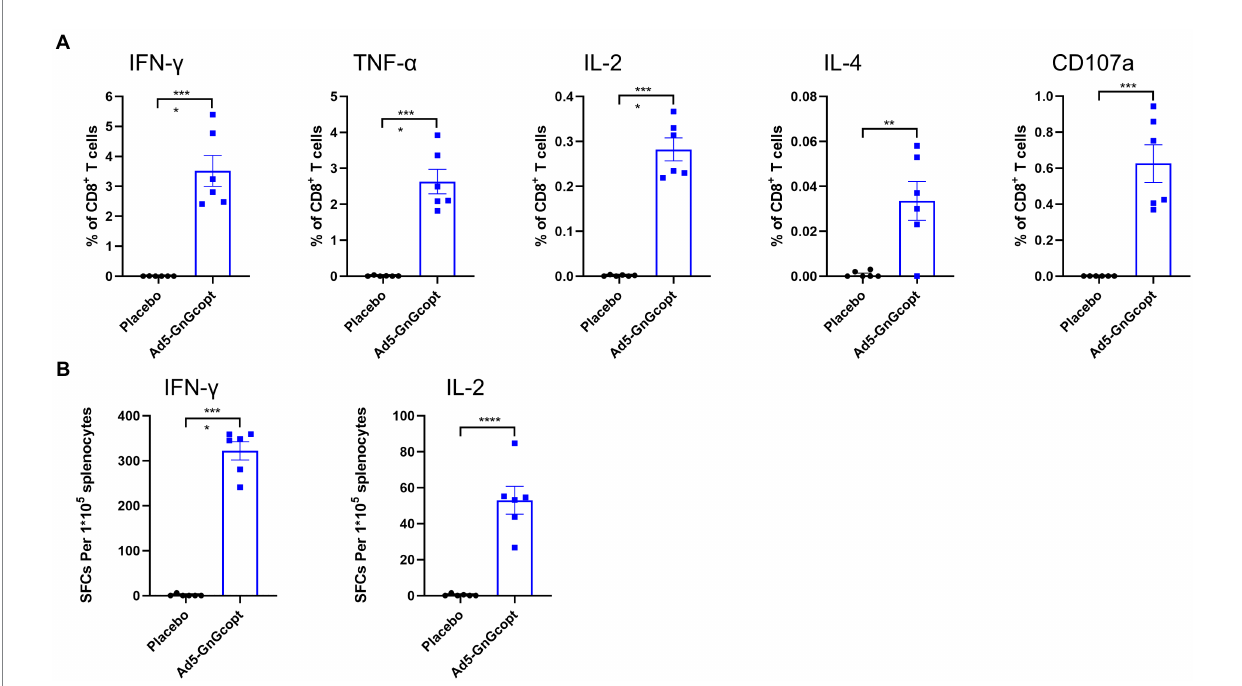
FIGURE 3 The cellular immune responses elicited by Ad5-GnGcopt in BALB/c mice. Four to six-week-old BALB/c mice ( n = 6) were immunized with a single injection of Ad5-GnGcopt (10 8 IFU) or placebo. The splenocytes were collected 2 weeks after immunization. (A) The percentages of CD8 + T cells secreting IFN- γ , TNF- α , IL-2, IL-4, and CD107a determined using intracellular cytokine staining assay. (B) IFN- γ and IL-2 secretion from mouse splenocytes detected by ELIspot. Data are shown as means ± SEM. Comparisons based on Student’s unpaired t -test with ** p < 0.01, *** p < 0.001, and **** p < 0.0001.